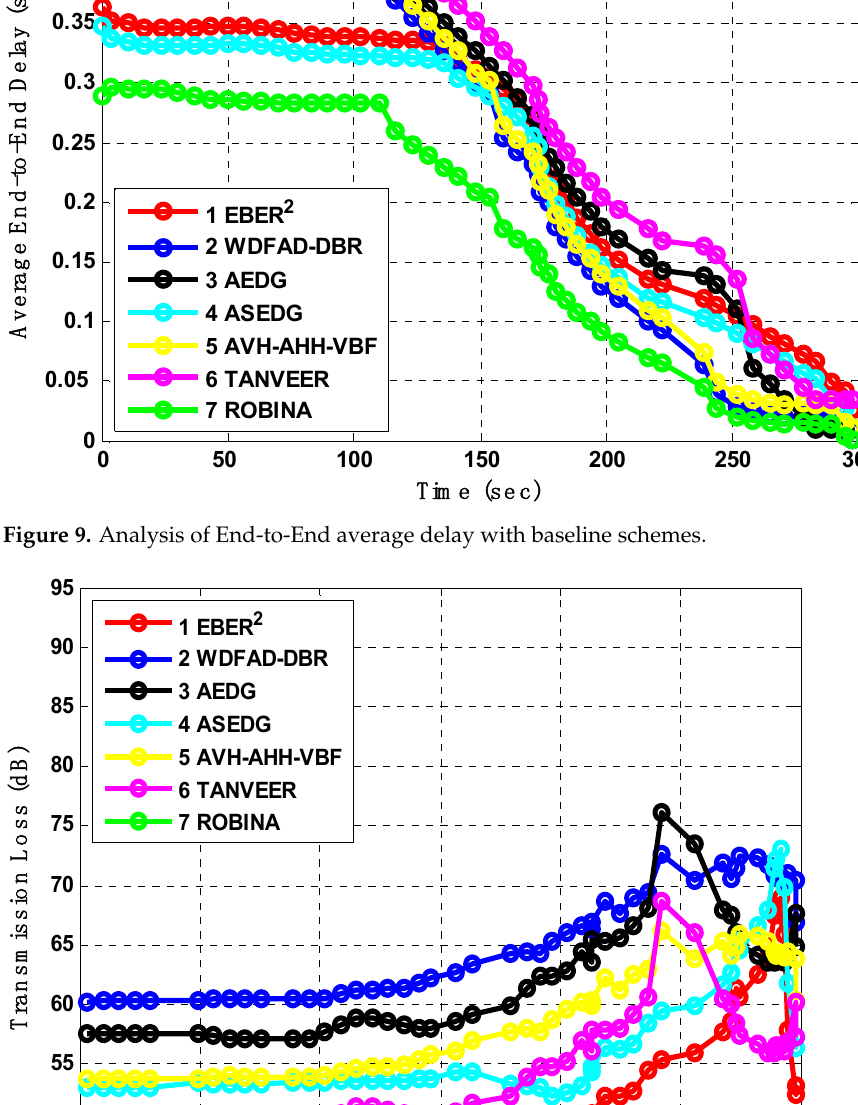
Figure 10. Analysis of average End-to-End delay with baseline schemes.